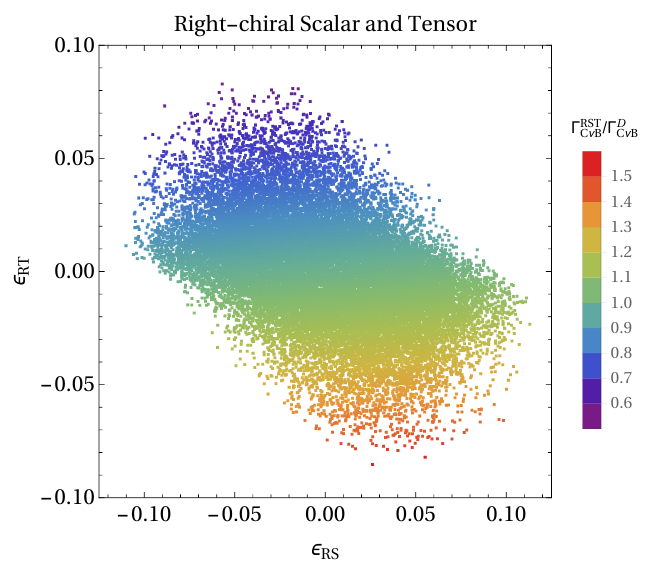
Figure 1. Ratio between the BSM capture rate for the right-chiral scalar and tensor couplings scenario with respect to the SM Dirac case in the plane ( (cid:15) RS versus (cid:15) RT ). We use a color code to indicate the range of values of the